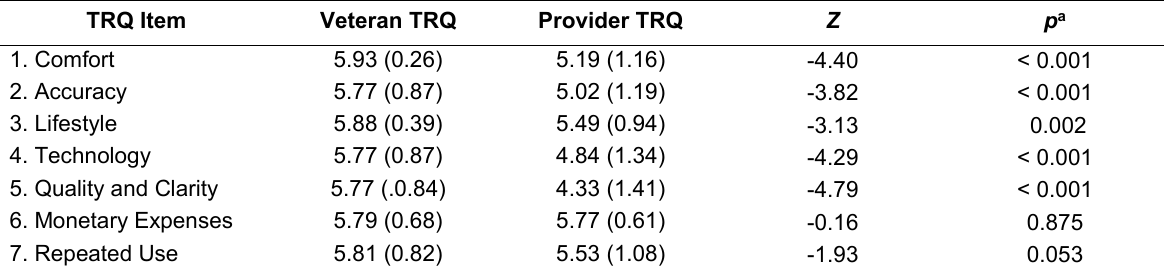
Veteran and Provider Wilcoxon Signed Rank